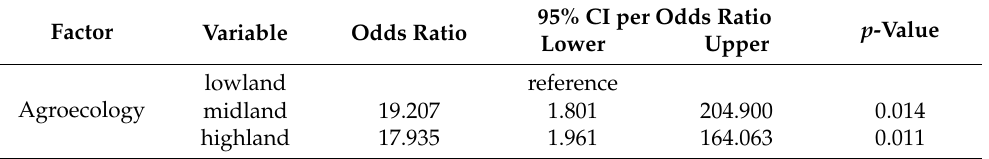
The multivariable logistic regression model developed for B. canis rossi (Table 4) identified agroecology as the most influential factor on the presence of the parasite, with midland and highland at higher risk compared to lowland. Table 4. Results of the logistic regression model for B. canis rossi (Hosmer–Lemeshow test: p =